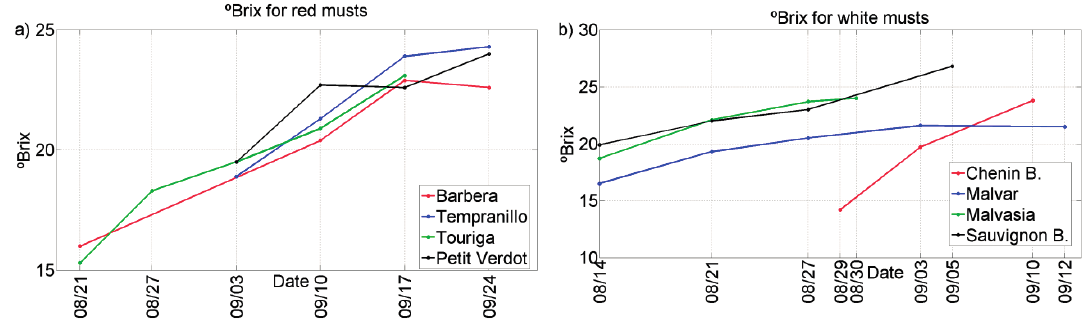
Figure 4. Evolution of ºBrix for musts of 2011 harvest. ( a ) Red musts; ( b ) White musts.